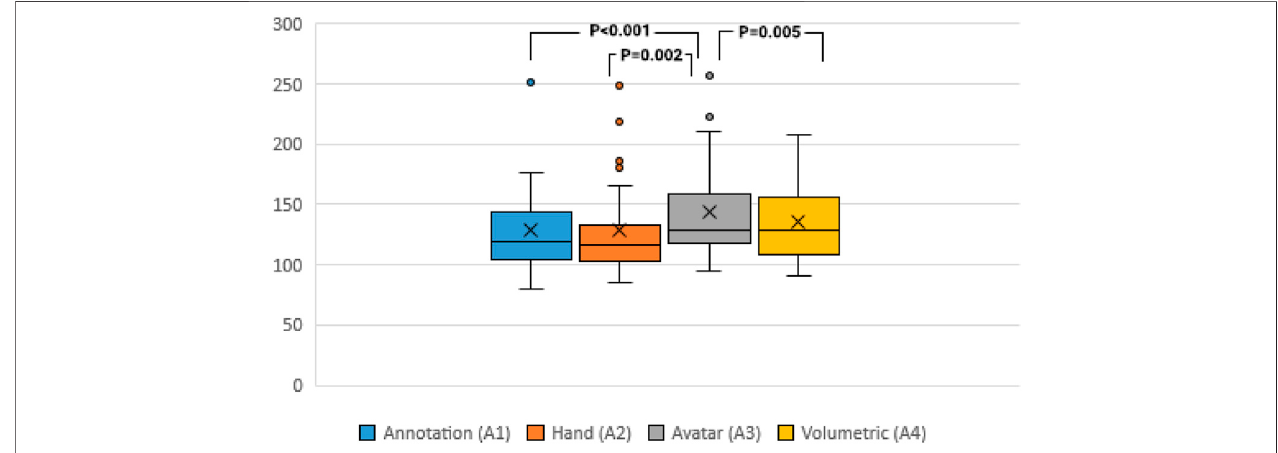
FIGURE 6 | Average task performance time (Unit in Second, the lower the better).